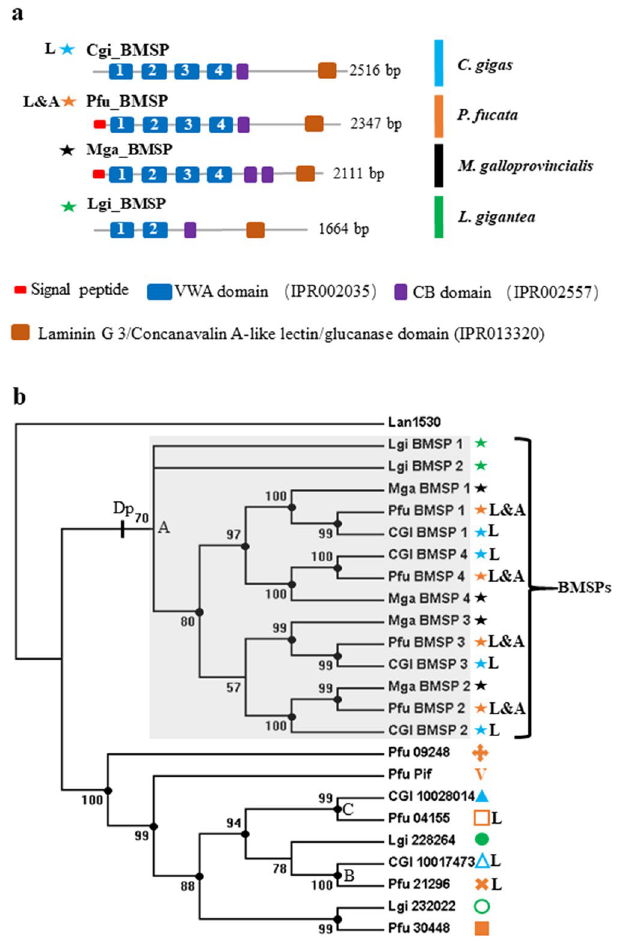
Figure 2. Phylogenetic analyses of VWA domains of VWA-CB dcps of molluscan shells. ( a ) Schematic representations of domain structures of shell-specific BMSPs. ( b ) A Bayesian tree based on the LG model and 187 amino acid residues. Polychotomy is generated if the posterior probability value of the node is < 50. Posterior probability values are shown if ≥ 50, and marked with black dots if ≥ 80. The same symbol marks as in Fig. 1 are used to denote different SMPs. Larval SMPs are marked by “L”, and Pfu-BMSP identified from both larval and adult shells of P. fucata is indicated by “L&A”. BMSP family proteins are indicated by bold characters. Cgi, Crassostrea gigas ; Pfu, Pinctada fucata ; Mga, Mytilus galloprovincialis ; Lgi, Lottia gigantea ; Lan, Lingula anatina ; Dp,